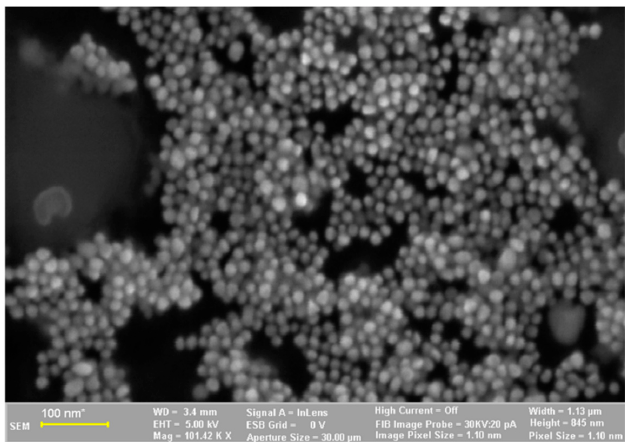
Figure 5. Two-dimensional image of the AuNPs obtained by the SEM technique.